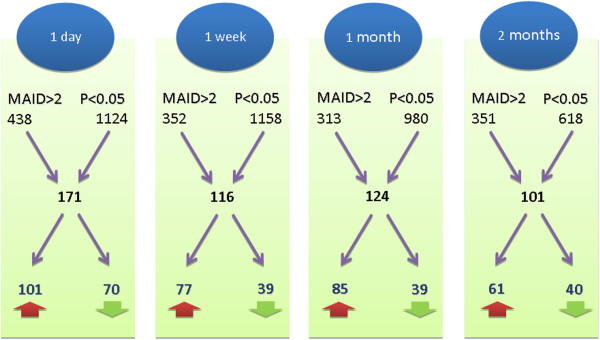
Longitudinal study design and gene filtering results. Blood was sampled from eight patients at five different time points: before the start of GA treatment as well as after one day, one week, one month and two months. The expression of 18,862 genes was measured in monocytes with Affymetrix microarrays, and transcript levels during therapy were compared to the pre-treatment levels. t-test P-values and MAID-scores were used to determine differentially expressed genes. For instance, when comparing the baseline levels with the expression levels after one day, 438 genes survived the MAID analysis criterion (|MAID-score| > 2) and 1,124 genes survived the paired t-test criterion (P-value < 0.05). In combination, this resulted in 171 filtered genes: 101 were up-regulated (red arrow) and 70 were down-regulated (green arrow). For each time point comparison, a similar number of genes were filtered. However, the overlap of these four gene lists was relatively small (n = 45). When taken together, 463 different genes were identified to be differentially expressed within the first two months of GA therapy.